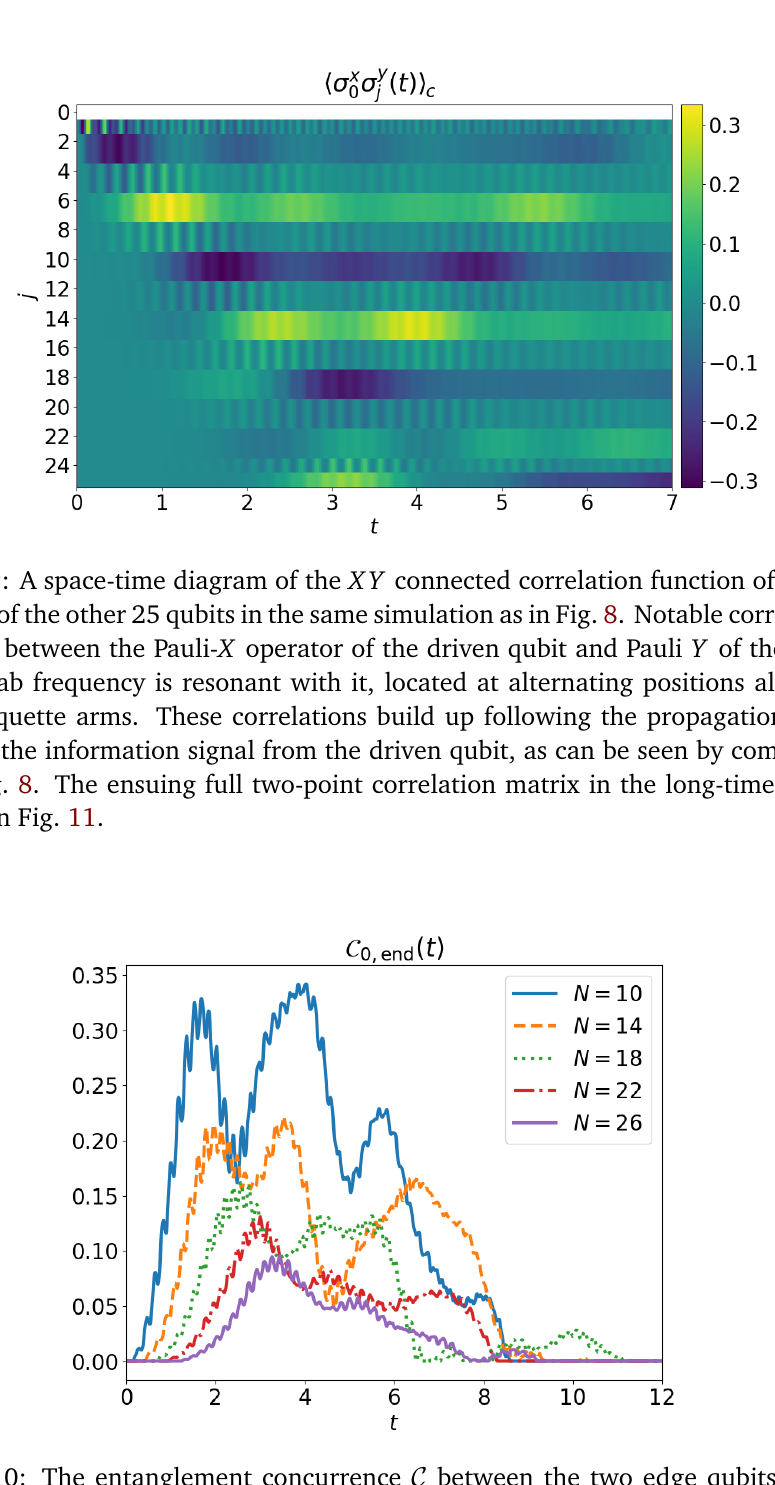
Figure 10: The entanglement concurrence C between the two edge qubits vs. the time t , for increasing system sizes in a plaquette topology. The parameters are given in Eqs. (33)-(34), with N indicated in the plot legend for each curve. Rich non- monotonous entanglement dynamics can be observed for different systems sizes – the entanglement peaks together with the two-point correlation functions, decreases and increases again as travelling excitations reflect from the system boundaries, and eventually the entanglement vanishes even though some correlators remain relatively large in the steady state. See the text for a